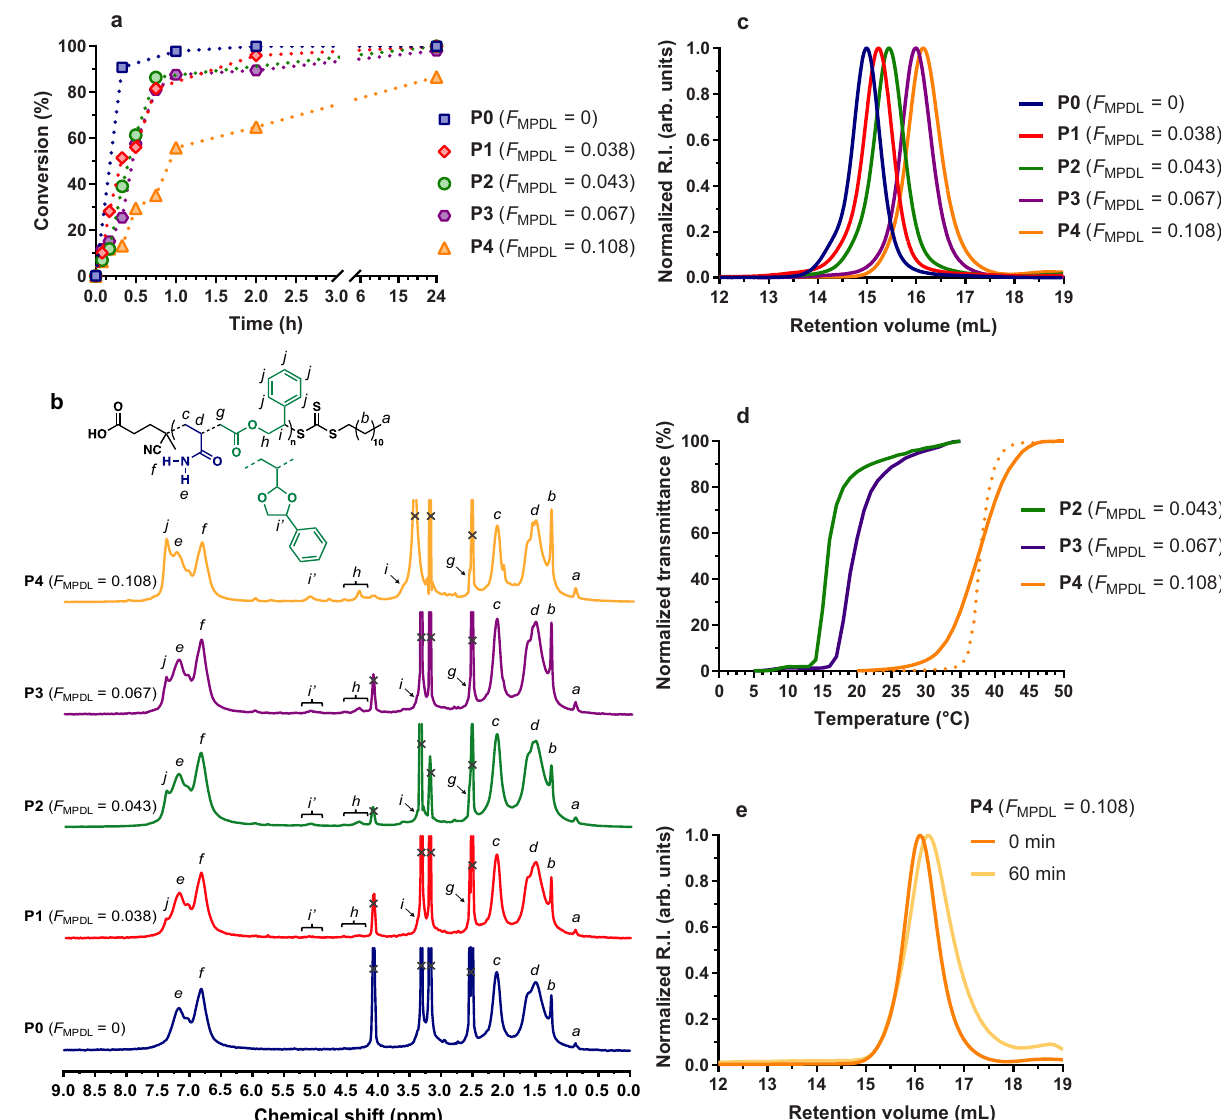
Fig. 3 Copolymerization kinetics and characterization of P(AAm- co -MPDL) copolymers. a Conversion vs. time kinetic plot from the RAFT copolymerization of AAm with MPDL (Table 1, P0 – P4 ) in anhydrous DMSO initiated by AIBN at 70 °C. Conversion = AAm conversion as determined by – 9 ppm region of P(AAm- co -MPDL) copolymers P0 – P4 (Table 1); c evolution of the SEC 1 H NMR; b 1 H NMR spectrum (300 MHz, DMSO-d 6 ) in the 0 chromatograms of P(AAm- co -MPDL) copolymers P0 – P4 as function of F MPDL ; d variation of the solution transmittance vs. temperature of P(AAm- co